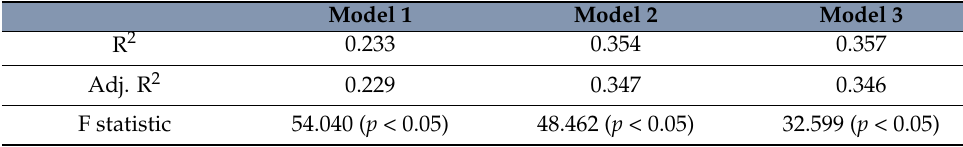
Table 6. Moderation